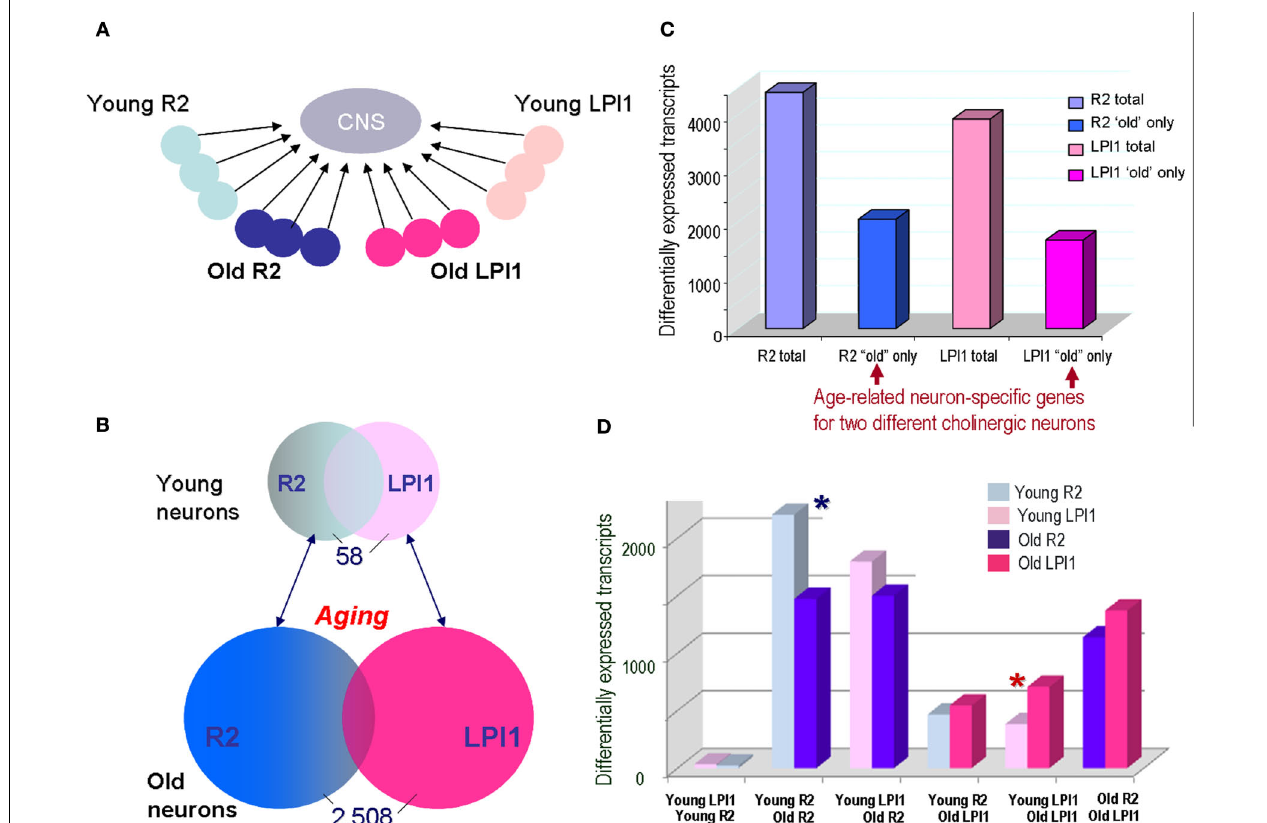
FIGURE 7 | Comparison of age-related changes in gene expression between two identifi ed cholinergic neurons LPl1 and R2. (A) The schematic representation of the reference design microarray experiments to compare two different cell types R2 and LPL1 during the aging process. In these microarray tests, individual neurons were compared to the same reference CNS sample [see Materials and Methods, and legends for (C,D) below]. The individual circles represent single neurons (LPl1 – red tones; and R2 – blue tones) from young or old animals. (B) We found that only 58 neuronal transcripts ( ∼ 0.1%) are differentially expressed when LPl1 and R2 neurons are compared from young animals. In contrast, when the same cells were directly compared from old animals, we identifi ed 2508 differentially expressed transcripts ( ∼ 4.5%). This suggests that identifi ed cholinergic motoneurons are more similar to each